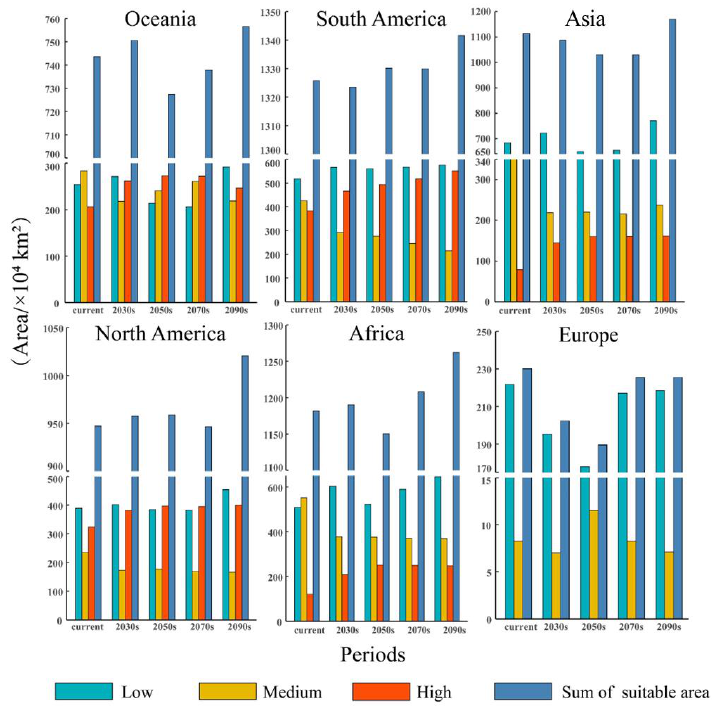
Figure 8. Area of the future potential global distribution of Anthonomus grandis under future climate scenarios in each continent.